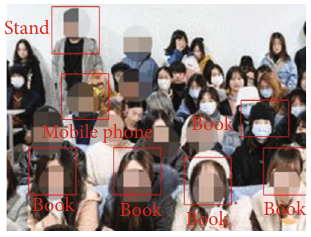
Figure 3: Student static recognition